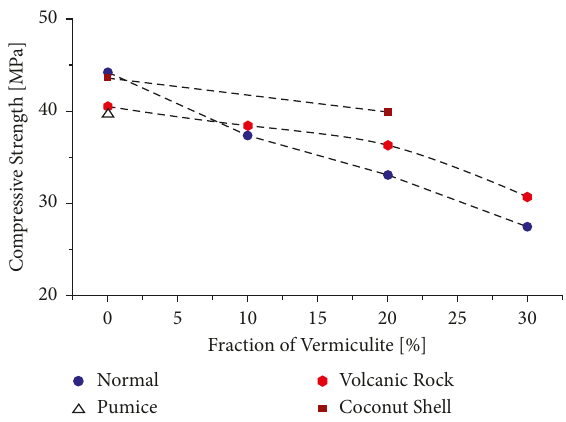
Figure 12: Compressive strength with a fraction of